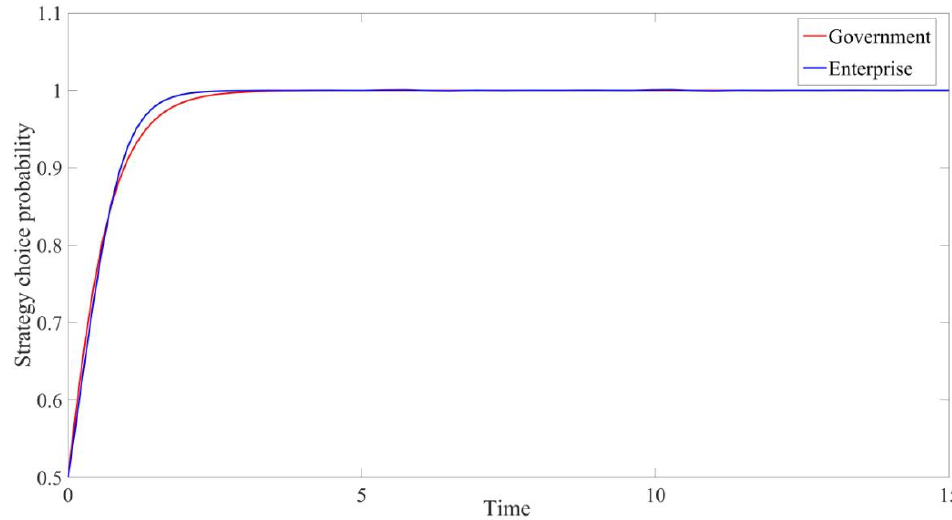
Figure 9. Simulation results of the partial equilibrium point (1,1).